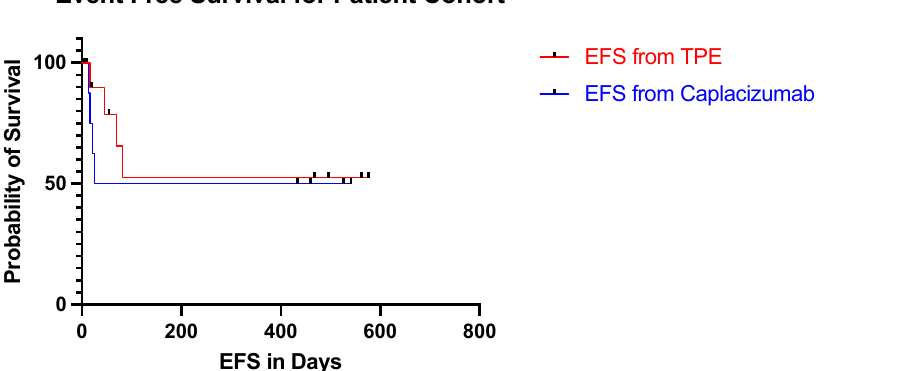
Figure 1. Kaplan–Meier Curves estimates the event free survival (EFS) of patient on caplacizumab from the initiation of therapeutic plasma exchange (TPE) and from the start of caplacizumab. Table 1. Patient Cohort Demographics.